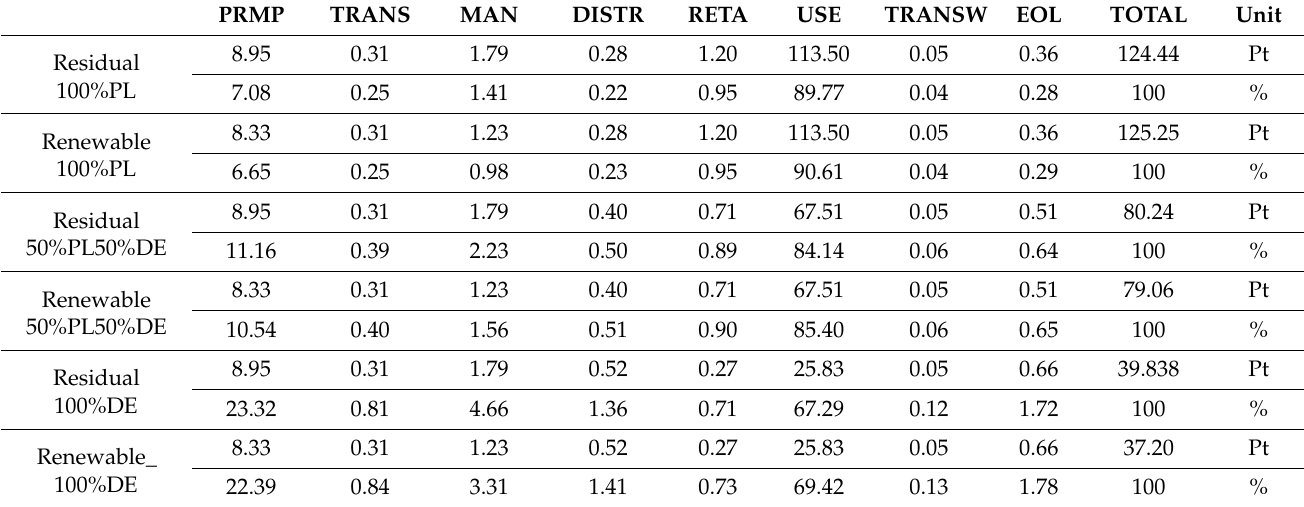
Figure 6. Environmental impact of the full life cycle of 1 refrigerator in different scenarios. Table 4. Environmental impact (single score) of the full life cycle of analysed refrigerator modelled in different scenarios (ReCiPe,